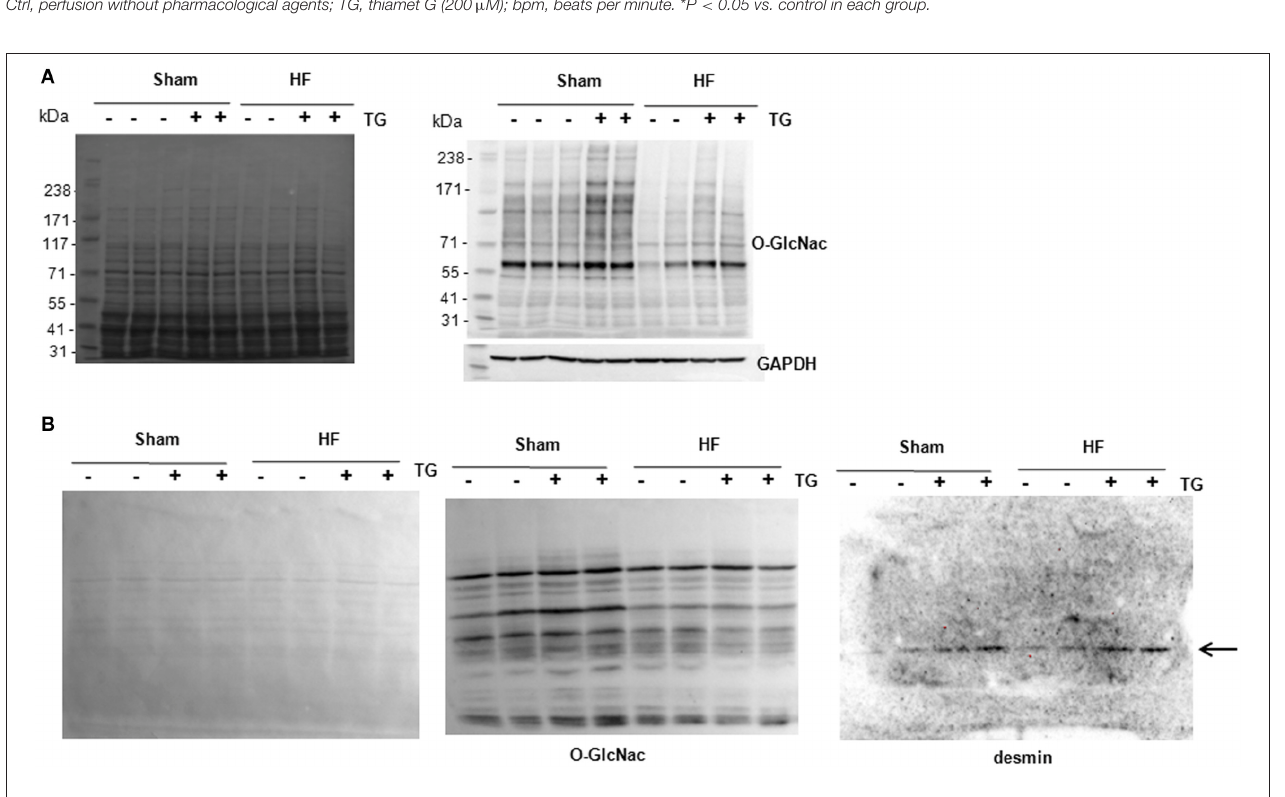
FIGURE 5 | Analysis of O-GlcNAcylated LV proteins by Western blot and WGA-SDS-PAGE gel electrophoresis. (A) Red ponceau staining (left panel) and western blot (right panel) of O-GlcNAcylated proteins (50 µ g) extracted from sham- and HF-rats treated or not with thiamet G. The positions of molecular weight are indicated as kilodalton (kDa) on the left. (B) Red ponceau staining (left panel) and WGA-SDS-PAGE of O-GlcNAcylated proteins levels (middle panel) of O-GlcNAcylated desmin levels (right panel) from the same samples. The arrow in desmin WGA gels indicates the non-O-GlcNAcylated